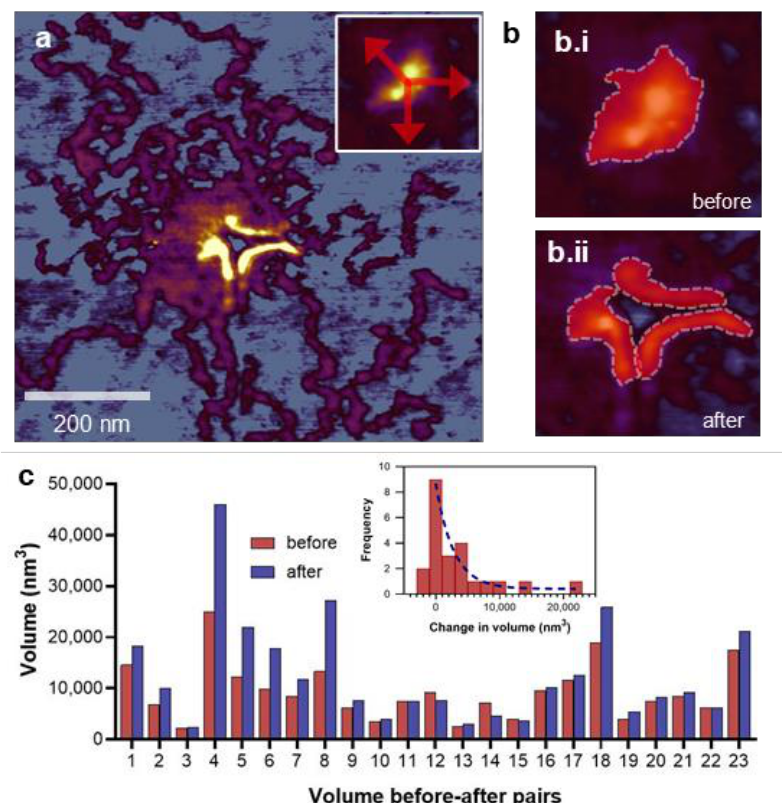
Figure 5. Volume changes in the nanosurgically manipulated M-complex. ( a ). AFM image of a M-complex nanosurgically manipulated in three different directions (indicated by red arrows in the inset). ( b.i , b.ii ): Method of comparing the a priori and a posteriori volumes of the M-complex by thresholding and masking. Red areas show the masked regions for volume analysis. ( c ). Pairwise analysis of the a priori and a posteriori M-complex volumes. ( Inset ), distribution of the change in volume of the M-complex as a result of nanosurgical manipulation. The distribution was fitted with the exponential function f = e − w ∆ V , where f is statistical frequency, ∆ V is volume change and w is the characteristic scale of mechanically evoked volume change in the M-complex (~30,000 nm 3 ). The r 2 value of the exponential fit is